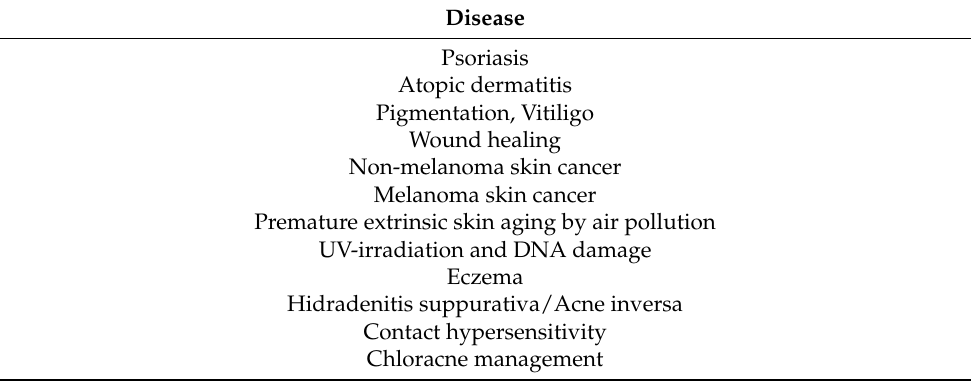
Table 2. Skin diseases with AHR-targeted treatment